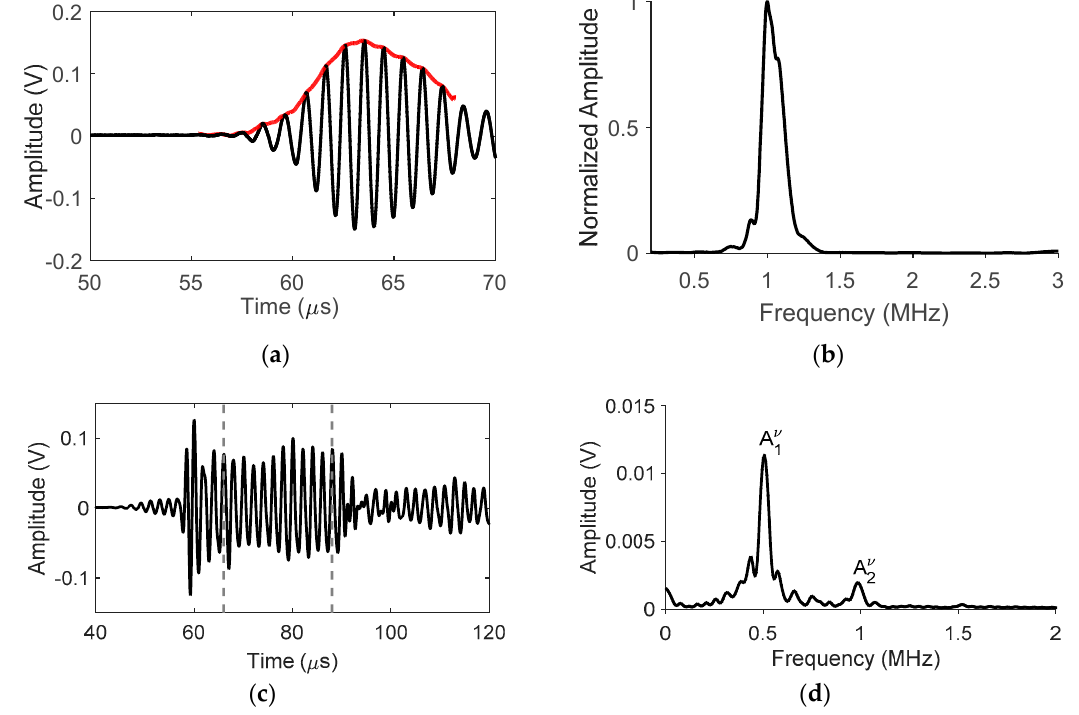
Figure 7. Examples of LUT and NLUT signals (P1) in ( a , c ) time domain, and ( b , d ) frequency domain.